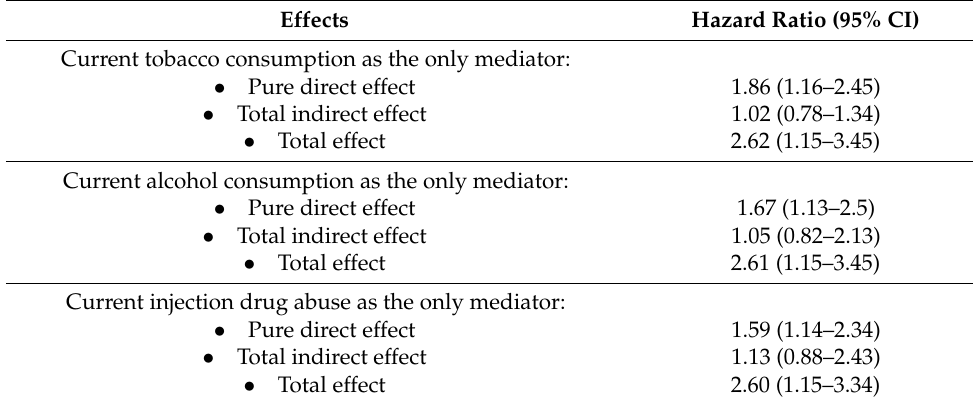
Table 3. Direct, indirect, and total effects of viral etiology on overall survival.